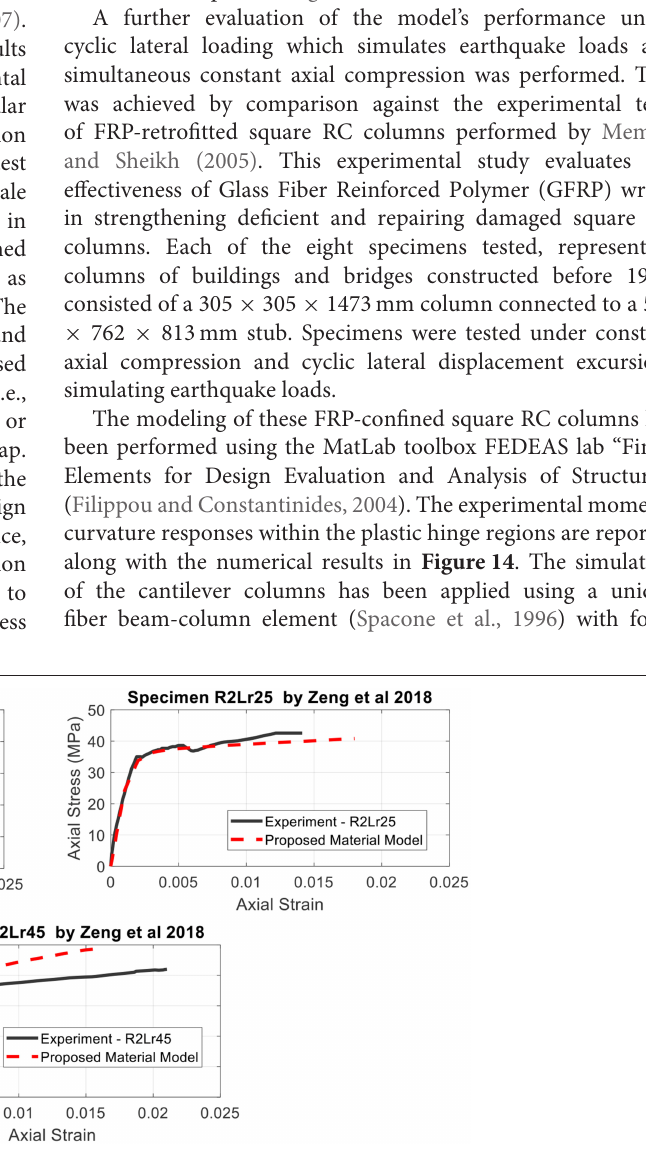
Frontiers in Built Environment |